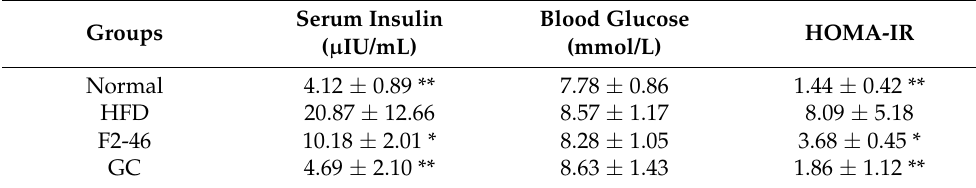
Table 5. Effect of F2 on fasting blood glucose, serum insulin, and HOMA-IR. Groups